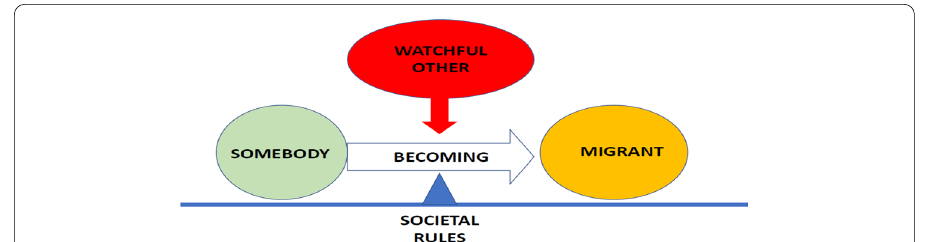
Fig. 3 The simple system of migrants and